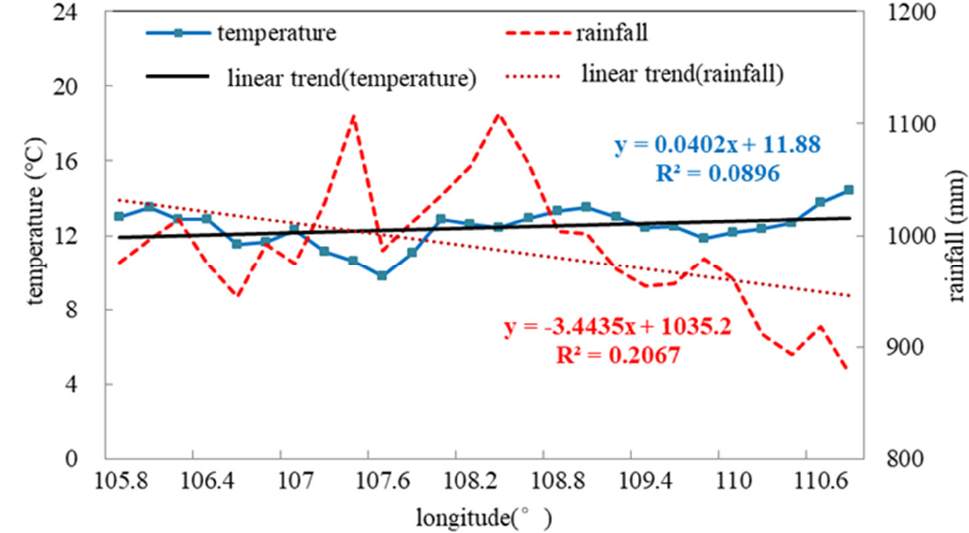
Figure 10. As in Figure 9, but for longitude in the QMs.